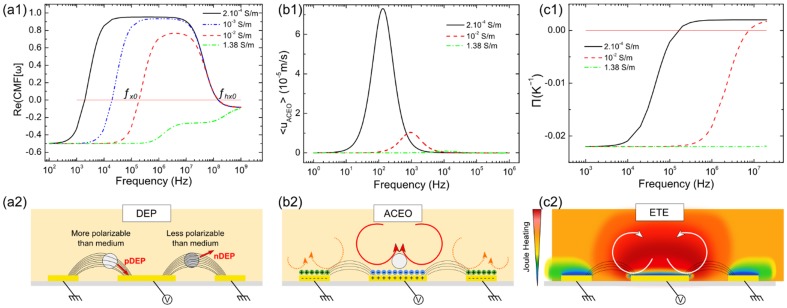
Plots of critical parameters and streamlines induced by AC electrokinetic forces.
(a.1) Plot of the real part of the Clausius-Mossotti factor for human cells with single shell models (parameters extracted respectively from [27] for HeLa-60) and σm  = 2.10−2 S/m, (b.1) Plot of the ACEO mean velocities of the fluid near the electrodes (x = 1 µm) for several conductivities of the fluidic medium for water (εf = 78) and (c.1) Plot of the Π factor as a function of frequency for several conductivities of the medium. Review of predominant forces in presence of AC electric field and the induced motion of liquid and cells: (a.2) Dielectrophoresis (DEP) induces attraction (p-DEP) or repelling (n-DEP) of cells from high field region (in co-planar cases, electrode edges), (b.2) AC electroosmosis (ACEO) are electrohydrodynamic forces that create convective rolls over the electrodes edges and drag cell with them and (c.2) electrothermal effects (ETE).